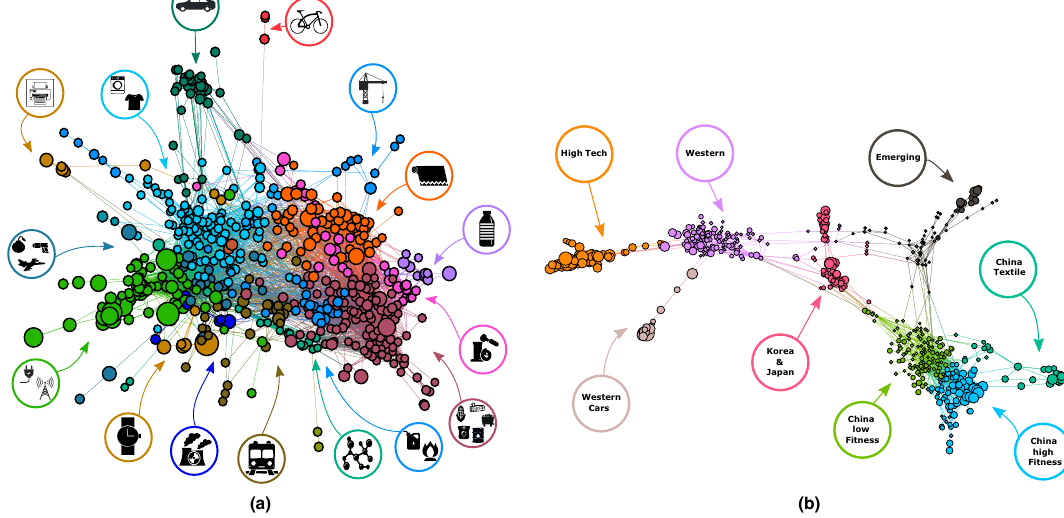
Figure 2. Monopartite projections of the metropolitan areas-technology bipartite network. (a) Technology network. Each node in this figure is a technology code. The size of the nodes is proportional to the complexity of the technology. We could identify the specific significant technologies for most clusters and represent them with corresponding icons in coloured circles. The Electricity and Information cluster (light green on the left) contains the most complex technologies. (b) Metropolitan areas network. Each node in this graph is a MA and each node size is proportional to the respective fitness. The high-tech cluster is the one containing the MAs with the highest